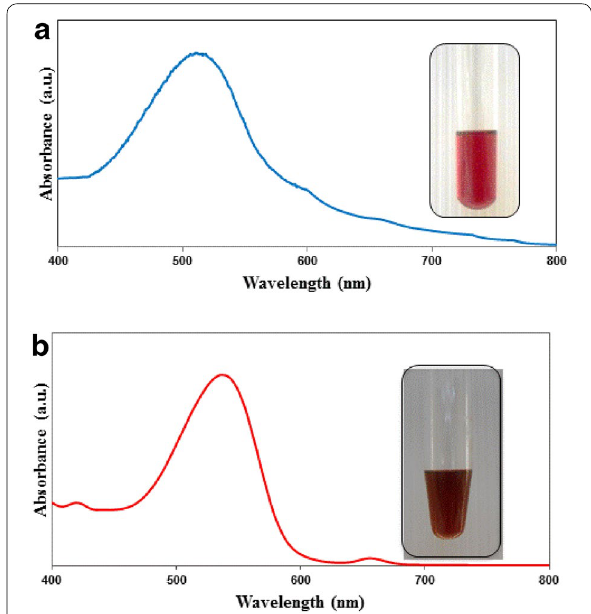
Fig. 5 Absorption spectrum of a Jamaica flowers and b the Mortiño fruit